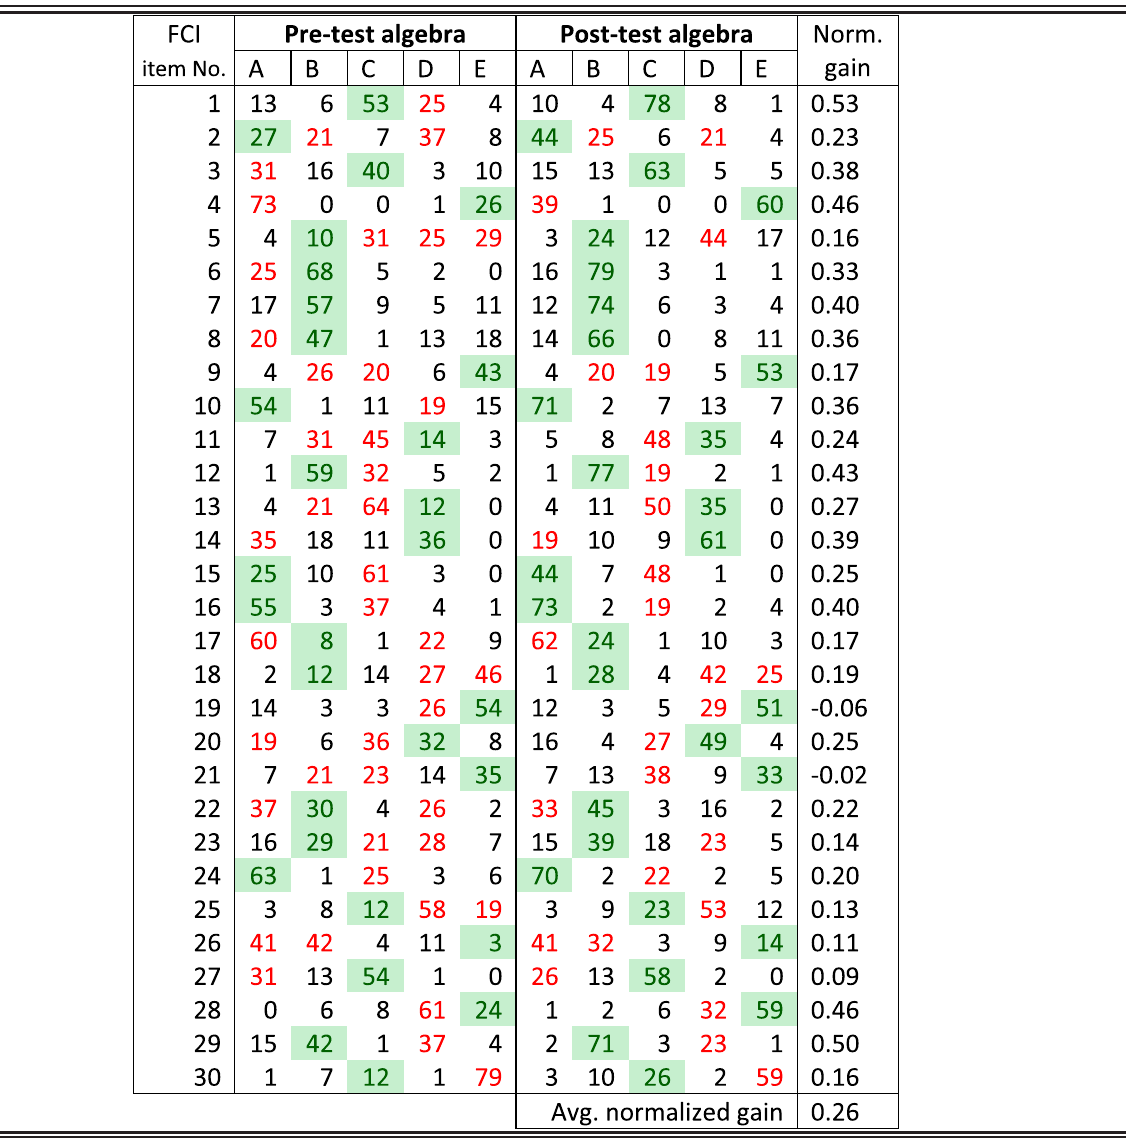
TABLE VIII. Percentages of algebra-based introductory physics students who selected each answer choice for each item on the FCI when it was given as a pretest and as a post-test and normalized gain (Norm. gain) on each item on the FCI. The percentages on the pretest are based on data from 601 students taught by two different instructors in two different semesters and the percentages on the post- test are based on data from 899 students taught by 4 different instructors over several years. The green shaded boxes indicate correct answers, and red font indicates incorrect answer choices selected by 20% or more students. All the courses were taught in a traditional manner which did not incorporate PER based teaching